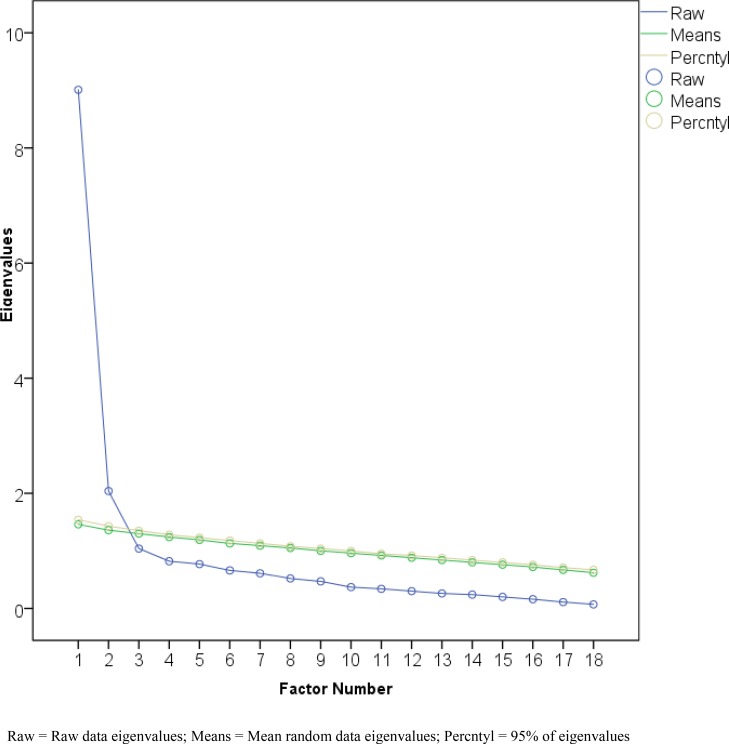
Scree plot illustrating the factor loadings with parallel analysis of the Chinese-Cantonese version of the Fear of Intimacy with helping professionals scale (C-FIS-HP) (N = 297).